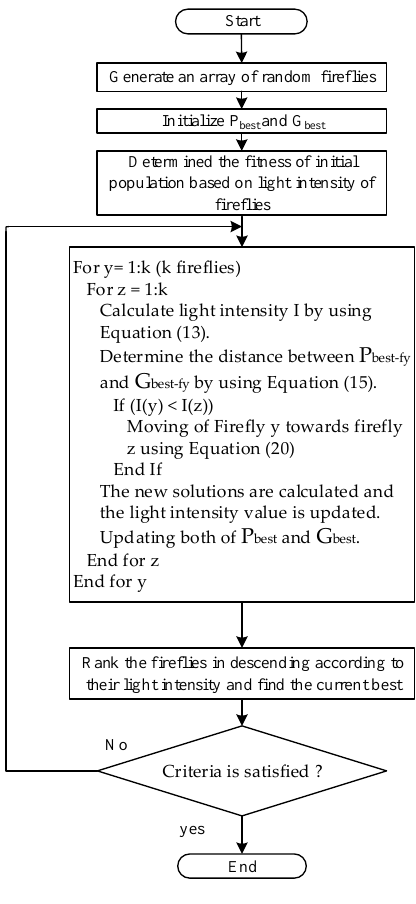
Figure 2. Flowchart of proposed algorithm (FAPSO).